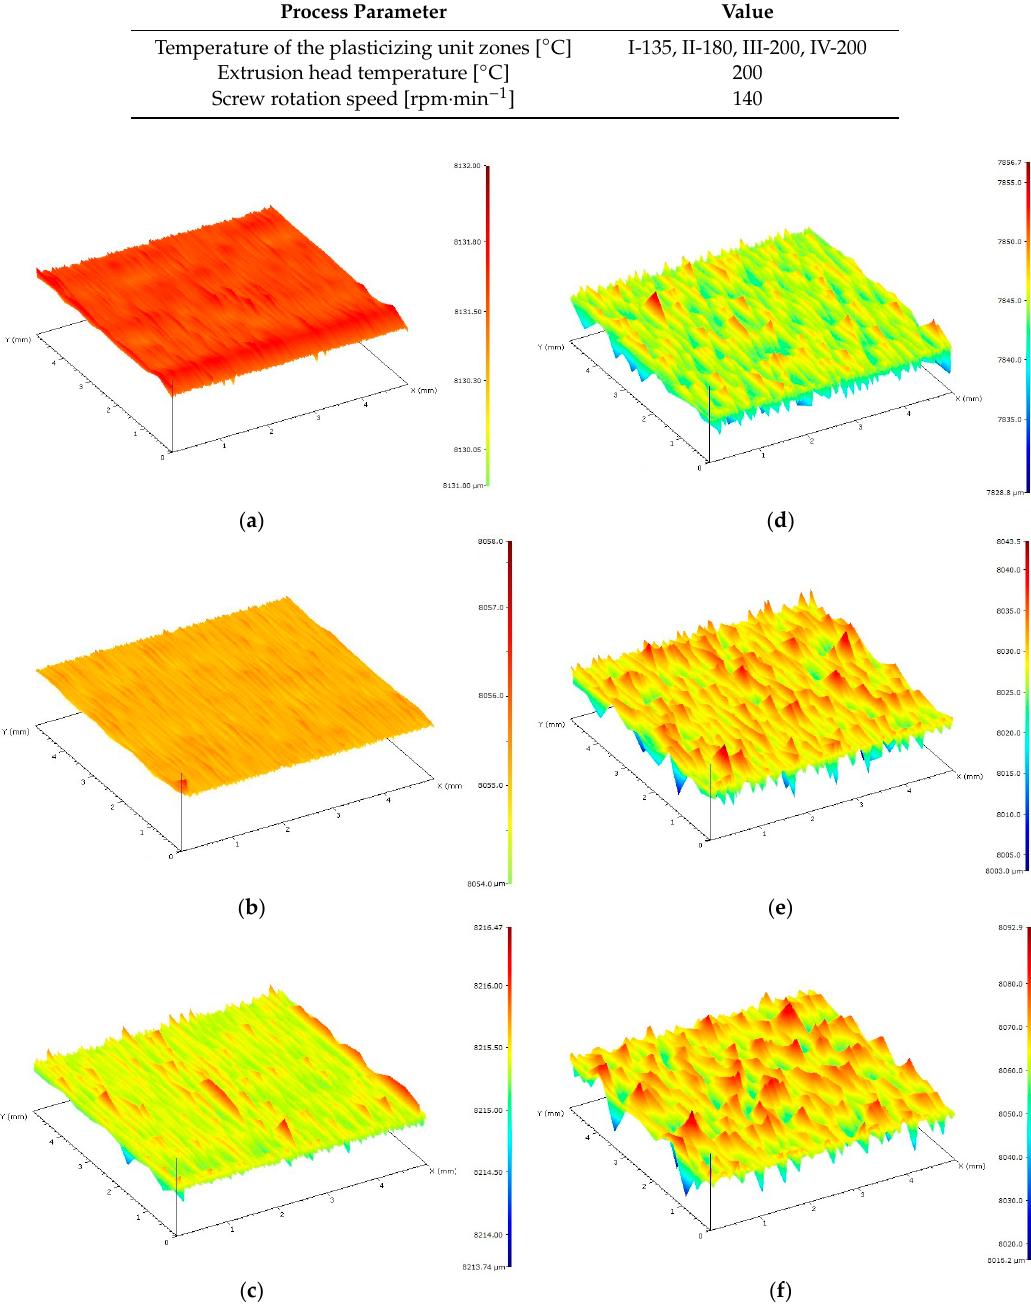
Figure 2. Sample images of surfaces of polypropylene (PP) specimens used in the research: ( a ) The polished one (P), ( b ) the ground one (S), ( c ) the honed one (O), ( d ) the electrical discharge machining Table 3. Surface topography parameters (average values) for the adopted types of the surface (EDM)(DA) one, ( e ) the EDM (DB) one, and ( f ) the EDM (DC) finishing of injection molding cavities used in the research and for the molded parts obtained in these cavities. Samples of PP without the addition of laser marking additives (LMA) and a mold temperature of 20 °C.